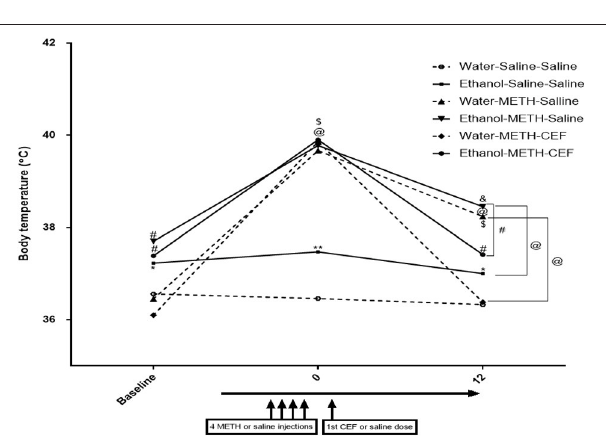
FIGURE 5 | Effects of METH (10mg/kg i.p. every 2h × 4), ethanol, and CEF posttreatment (200mg/kg, i.p.) on body temperature compared to Water-Saline-Saline control group. Ethanol pretreatment significantly elevated body temperature at baseline compared to water pretreatment. METH significantly elevated body temperature in all groups after the last METH injection (time 0) compared to Water-Saline-Saline group. CEF posttreatment restored body temperature compared to saline posttreatment in water and ethanol-METH treated rats. * p < 0.05, ** p < 0.01, # p < 0.001, and @ p < 0.0001 ( & p < 0.01, $ p < 0.001 compared to baseline point) (mixed-model repeated measure factorial ANOVA). Values are represented as mean ± SEM (Error bars were deleted for clarity). n = 7–9 for each